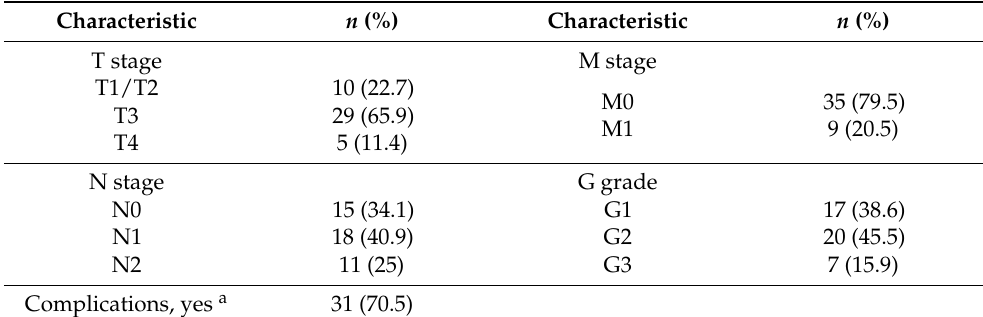
Table 3. Distribution of stage, differentiation grade, and complications in patients with CRC at the inclusion in the